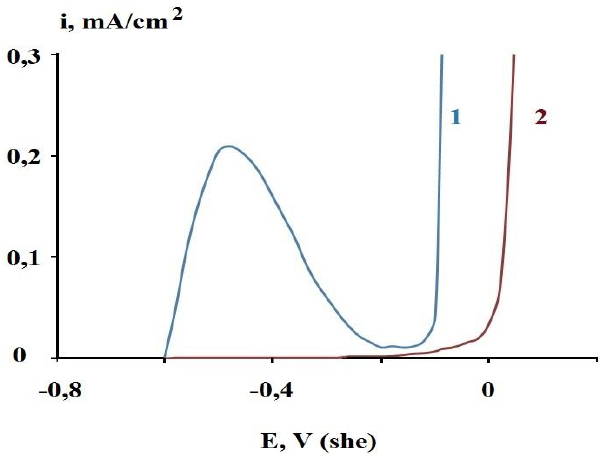
Figure 7. Anodic potentiodynamic polarization curves of St3 carbon steel. 1. Nonmodified steel; 2. - steel modified with 5 mM aqueous solution of BTA. Borate buffer solution with the addition of 0.01 M NaCl, pH 6.7. Potential sweep rate: 0.1 mV/s.